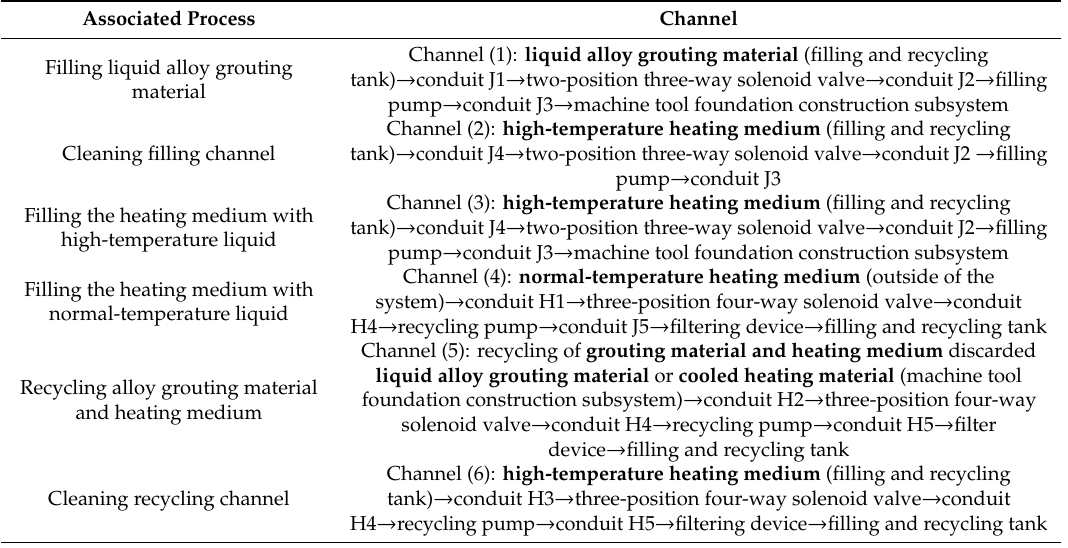
Table 3. Material transportation